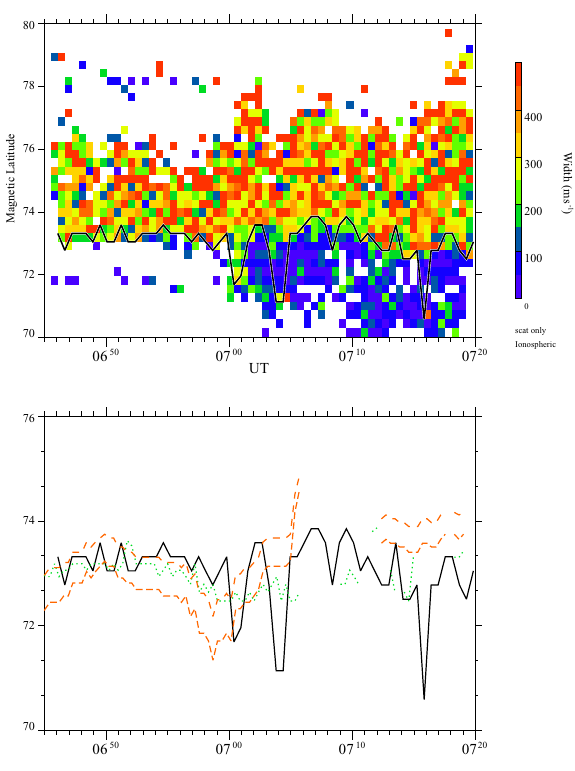
Fig. 6. The upper panel shows the spectral width component mea- sured along beam 9 of the CUTLASS HF radar as a function of UT, colour-coded in velocity between 0–500m s − 1 , with the ground scatter removed. The solid black line marks the southernmost lat- itude of spectral widths > 250ms − 1 . The lower panel then com- pares this boundary (solid black line) with the poleward edge of the lower band of 557.7nm emissions (green dotted line), as previously shown in Figs. 3–4, assuming an emission altitude of 150km. Also shown here is the latitudinal variation of the equatorward edge of the 5kR contour in the 630.0nm emissions plotted as a function of local time, assuming a range of emission altitudes between 200km and 250km, marked by the upper and lower red lines,